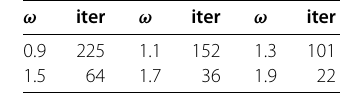
Table 1 Comparisons of ω ω iter ω iter ω iter 0.9 225 1.1 152 1.3 101 1.5 64 1.7 36 1.9